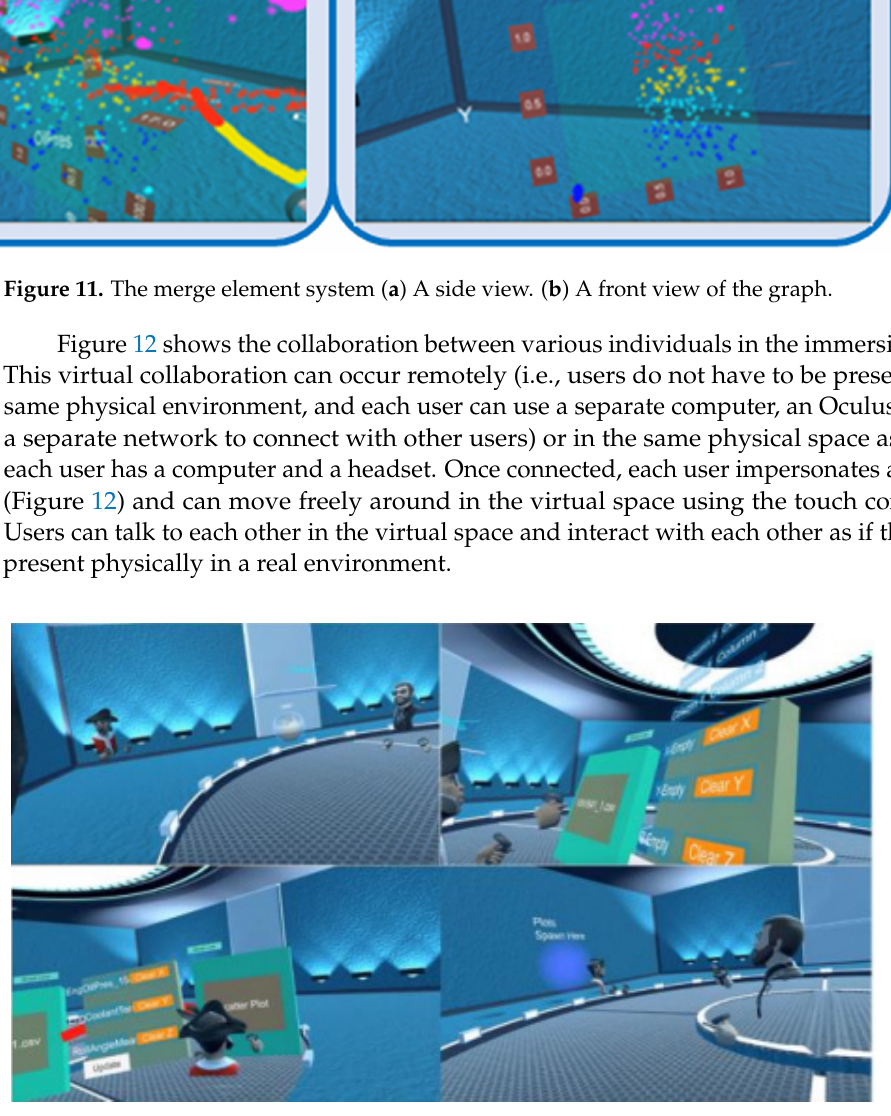
Figure 12. Collaboration in IVEE.